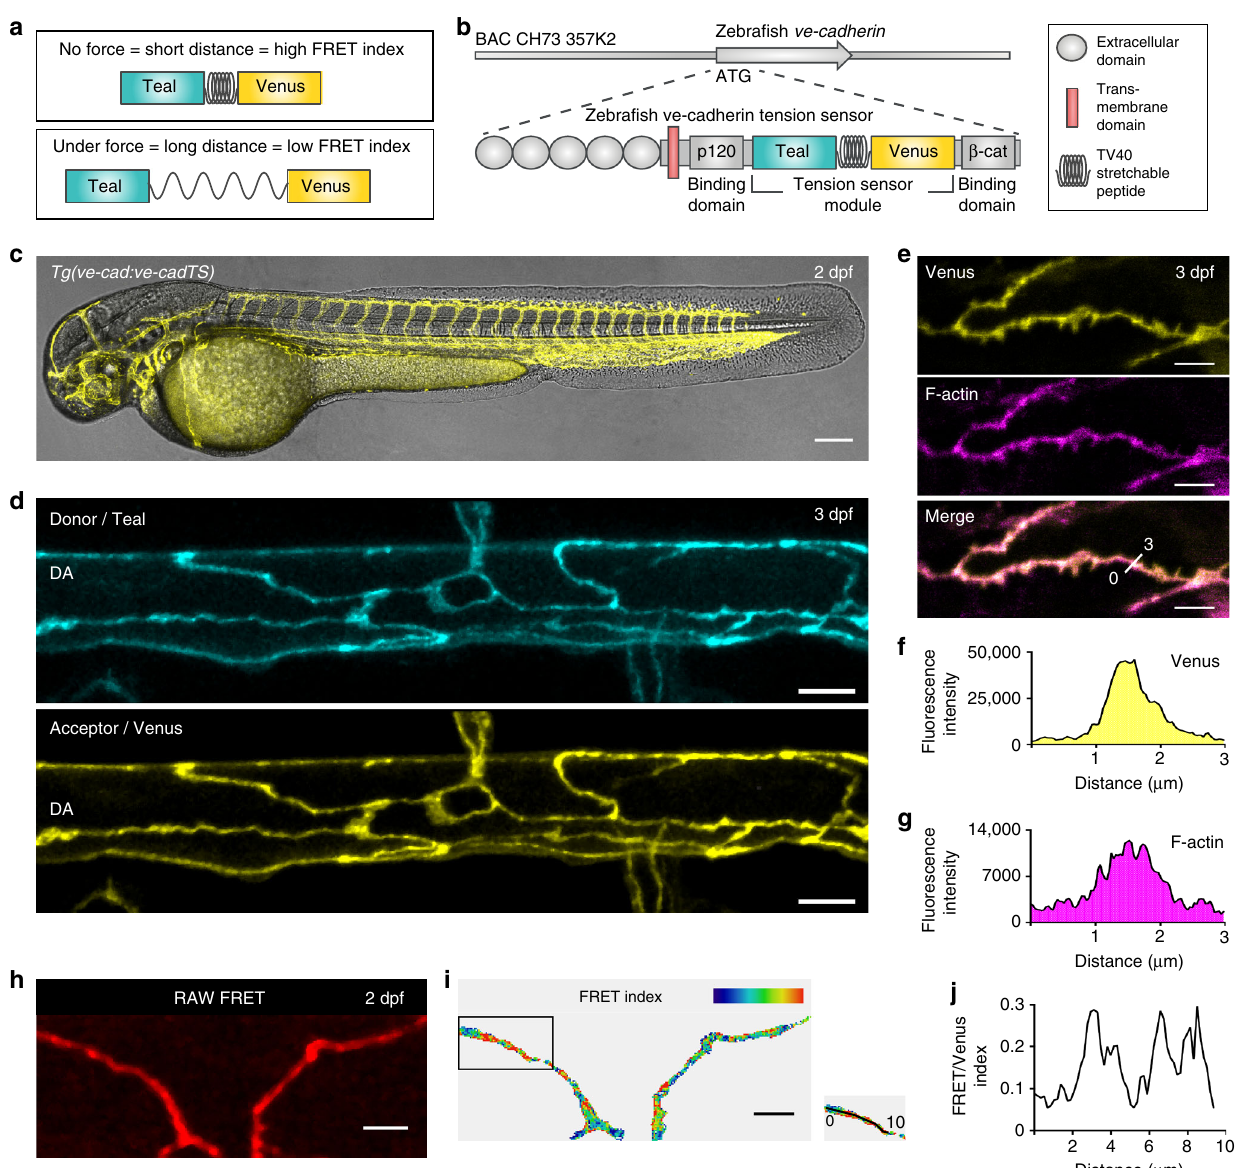
Fig. 1 VE-cadherin-TS is localized to cell-cell junctions and reports a differential FRET signature. a Schematic representation of the tension sensor (TS) module. The Donor fl uorescent protein, Teal, is separated from the acceptor, Venus, by a stretchable linker peptide (top). When the module is under tension (bottom), energy transfer from Teal to Venus will decrease. b Schematic of zebra fi sh VE-cadherin-TS cDNA recombined into the ve-cadherin BAC clone. c Venus expression from Tg ( ve-cad:ve-cadTS ) throughout the blood vasculature at 2 dpf. Scale bar = 150 μ m. d Maximum projection of the dorsal aorta (DA) at 3 dpf showing expression of Teal (top) and Venus (bottom) localized at cell – cell junctions. Scale bar = 10 μ m. e Co-expression (Merge, bottom) of Venus (yellow, top) from Tg ( ve-cad:ve-cadTS ) and Tg ( fl i1ep:lifeact-mCherry ), labeling F-actin (purple, middle), in endothelial junctions at 3 dpf. Scale bar = 5 μ m. f – g Fluorescence intensity of Venus ( f ) and Tg ( fl i1ep:lifeact-mCherry ), labeling F-actin ( g ), along a single 3 μ m line-region in a single Z- section (shown in e ). h RAW FRET signal at endothelial junctions at 2 dpf. Scale bar = 5 μ m. i Ratio-metric FRET signal at 2 dpf in endothelial junctions (shown in h) . Scale bar = 5 μ m. j Variable ratio-metric FRET values along a single 10 μ m line-region in a single Z-section in a proportion of the junction (boxed in i